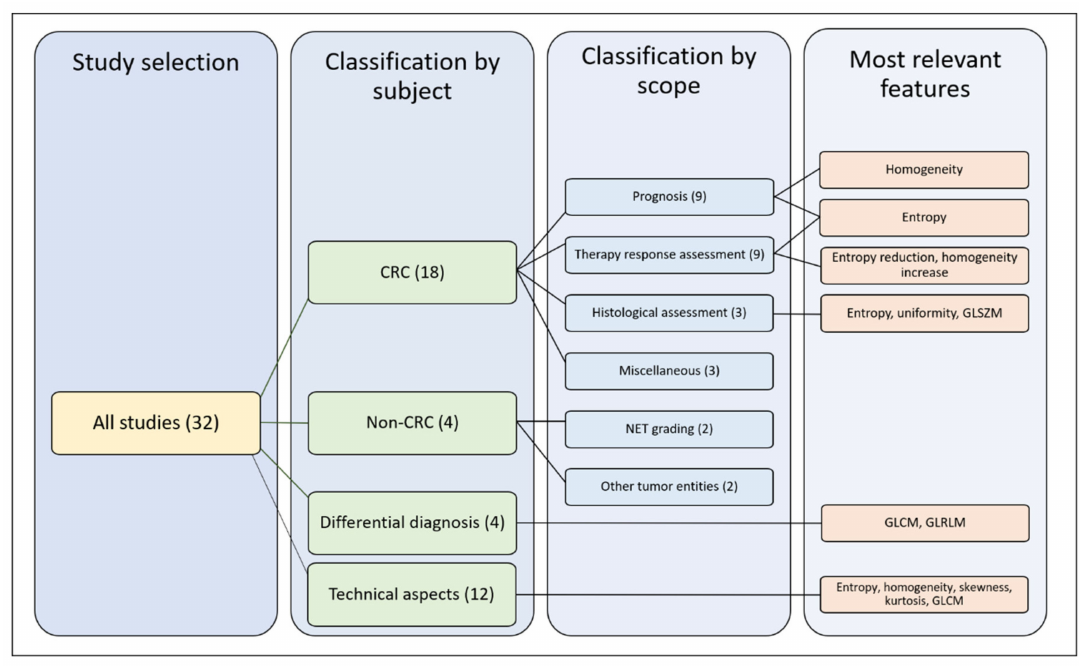
Figure 2. Outline of the selected studies organization. CRC: colorectal cancer, GLSZM: gray level size zone matrices, GLCM: gray level co-occurrence matrices, GLRLM: gray-level run-length matrices.